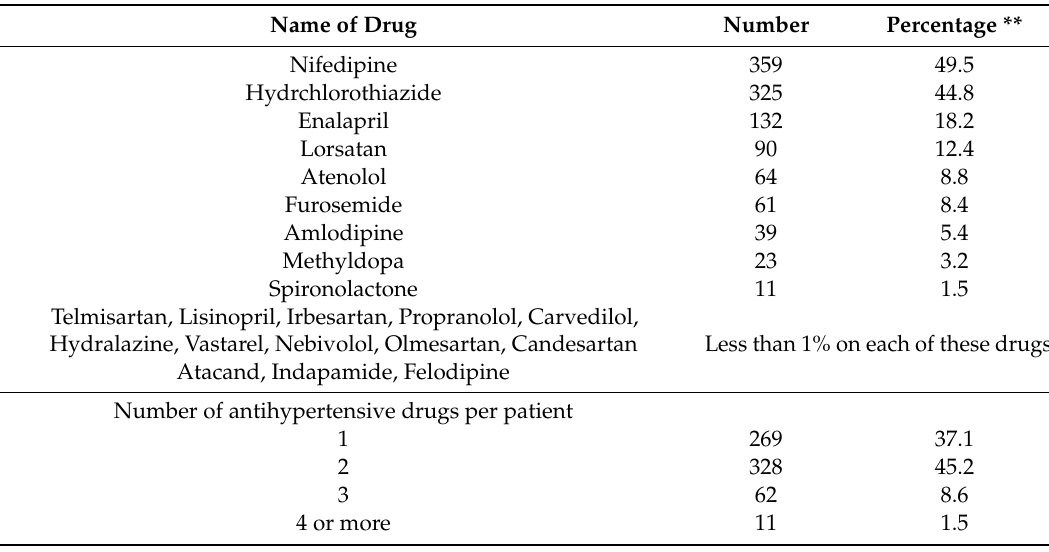
Table 5. Use of antihypertensive drugs in patients with hypertension ( N = 725